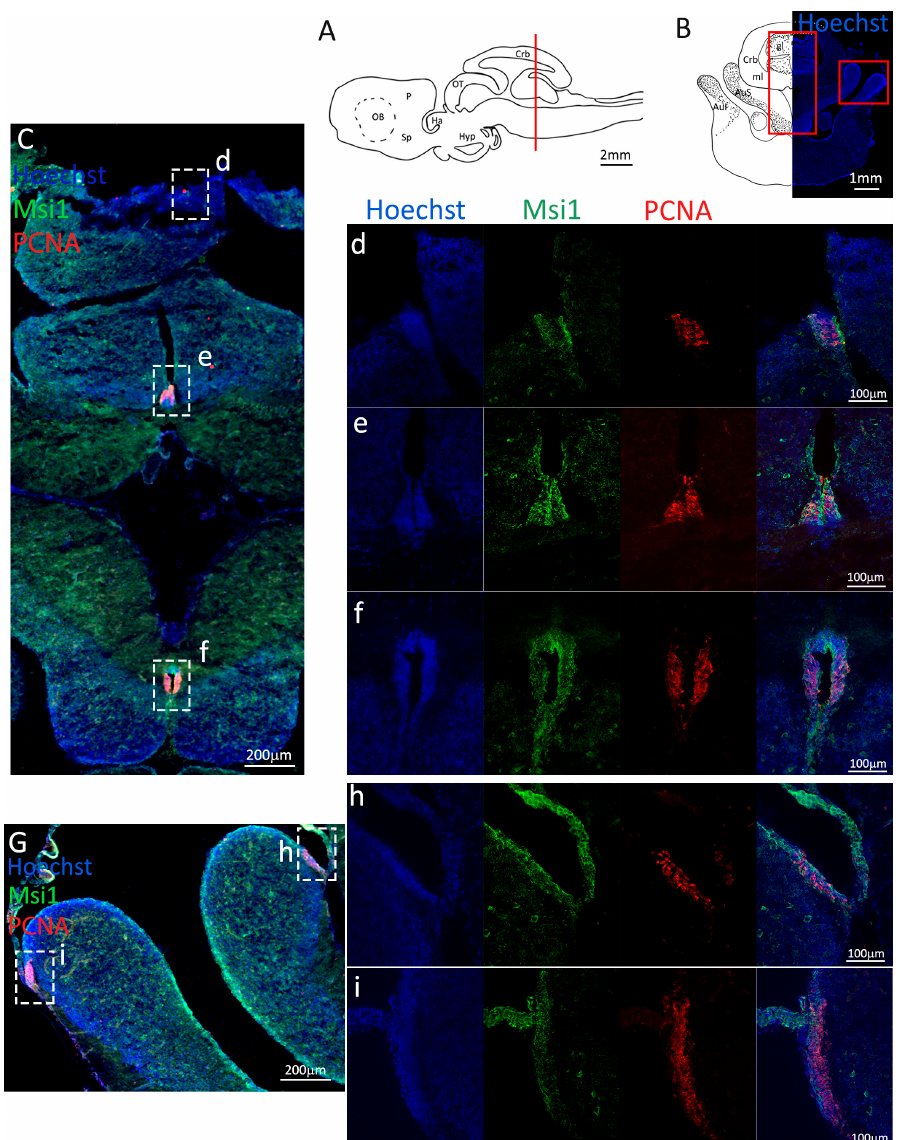
Figure 18. Localization of PCNA (red) and Msi1 (green) positive cells in the anterior cerebellum of S. canicula . ( A ) Sagittal representation of S. canicula brain. The red line indicates the rostro-caudal localization of the section represented in the panel. ( B ) Coronal map of the area imaged. On the right, a real coronal section is stained with Hoechst 33342 to show nuclei distribution; on the left, a cartoon is drawn to indicate anatomical references. Red rectangles identify the general area from which images are taken. ( C ) Neurogenic niche of the cerebellum and medial dorsal auricle. ( d ) Magnification of the neurogenic niche localized in the dorsal cerebellum. ( e ) Magnification of the neurogenic niche localized in the ventral cerebellum. ( f ) Magnification of the neurogenic niche localized in the medial superior cerebellar auricle. ( G ) Lateral neurogenic niches of the cerebellar auricles. ( h ) Lateral neurogenic niche of the superior auricle. ( i ) Neurogenic niche of the inferior auricle. Abbreviations: Crb: cerebellum, gl: granular layer, ml: molecular layer, AuS: superior cerebellar auricle, AuI: inferior cerebellar auricle. pH3 staining (Figure 19, green) confirmed the presence of a really high number of actively dividing cells in the cerebellar niches (Figure 19c,d), and also a good number of